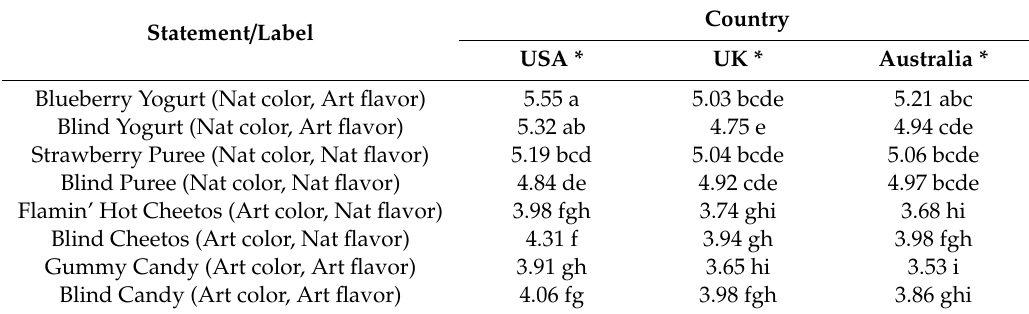
Table 3. ANOVA results of US, UK, and Australian participants’ naturalness scores to identified and unidentified products with various combinations of artificial (art) and natural (nat) colors and